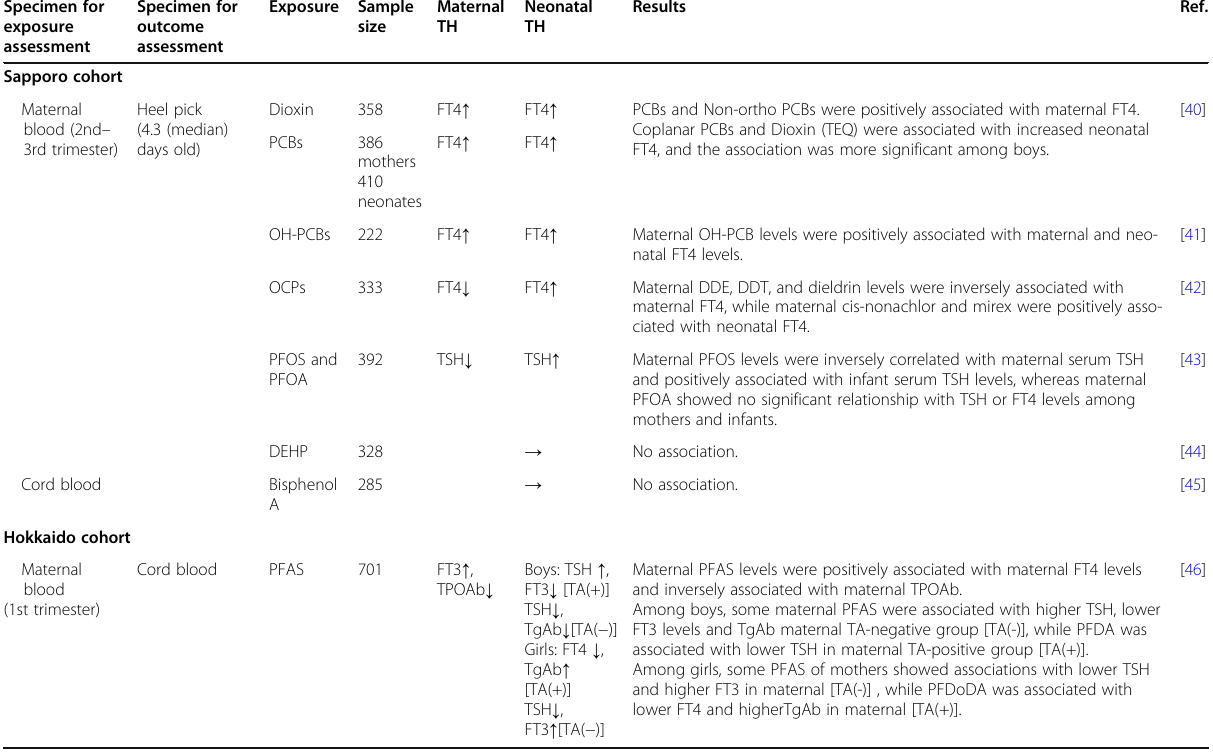
↑ / ↓ Arrows indicate the following: ↓ inversely associated ( p < 0.05); ↑ positively associated ( p < 0.05); and → no significant association. Blanks indicate not measured